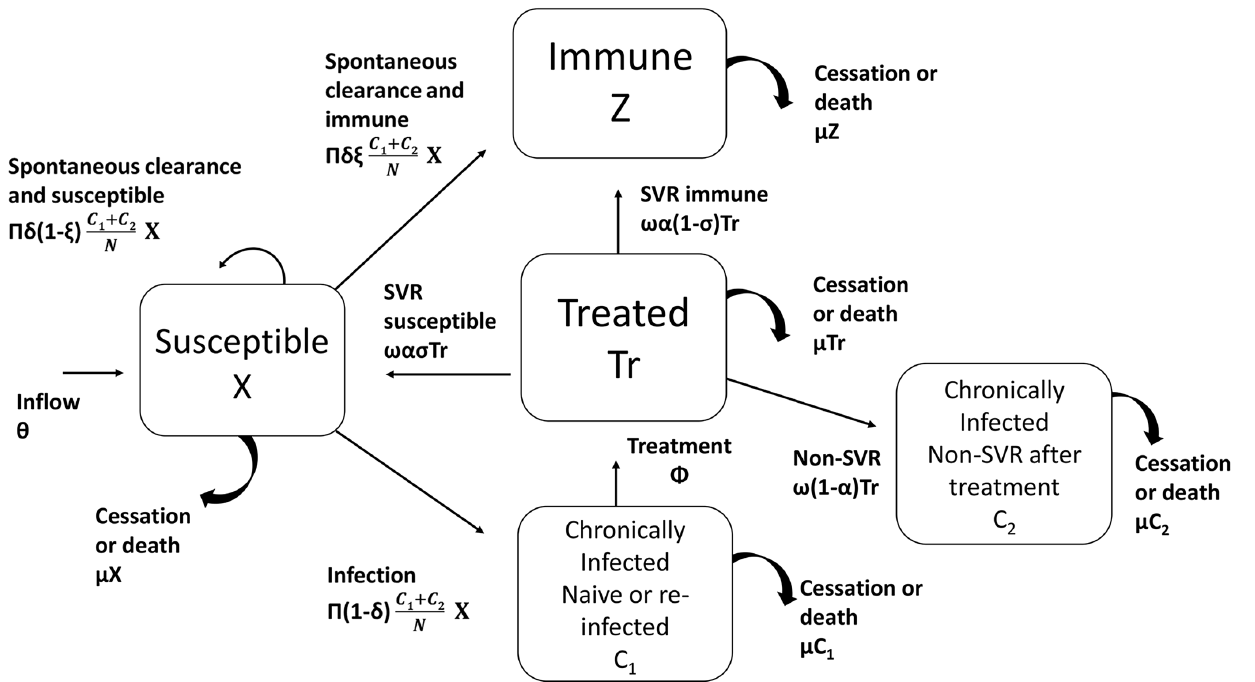
Fig 1. Schematic description of Martin et al. [17] mathematical model. N represents the total PWID population (X+Tr+Z+C 1 +C 2 ). Model parameters are described in Table 1.